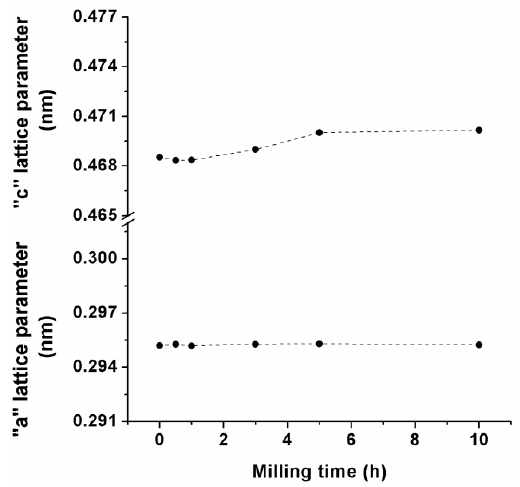
Figure 4. Lattice parameters of α-Ti as a function of milling time.